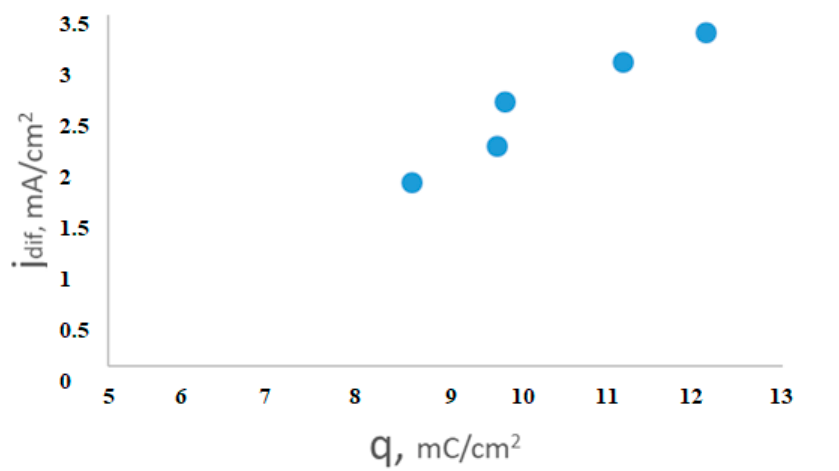
Figure 11. Influence of an electrochemically active surface on the limiting current for the synthesized catalysts.